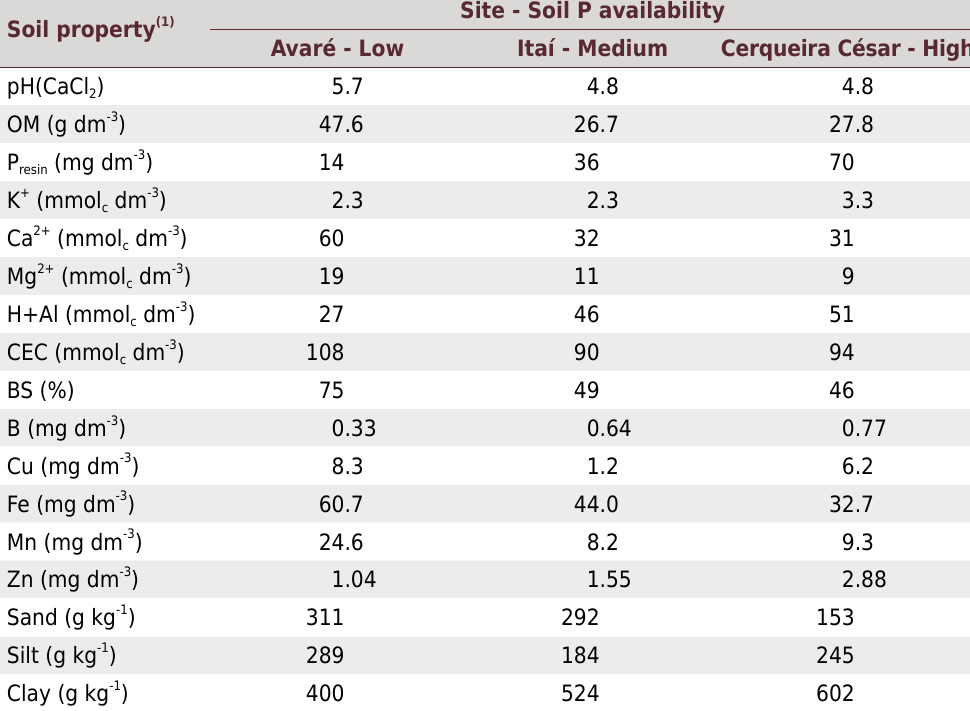
Table 1. Chemical and textural properties of the soils in the experimental areas before potato planting Soil property